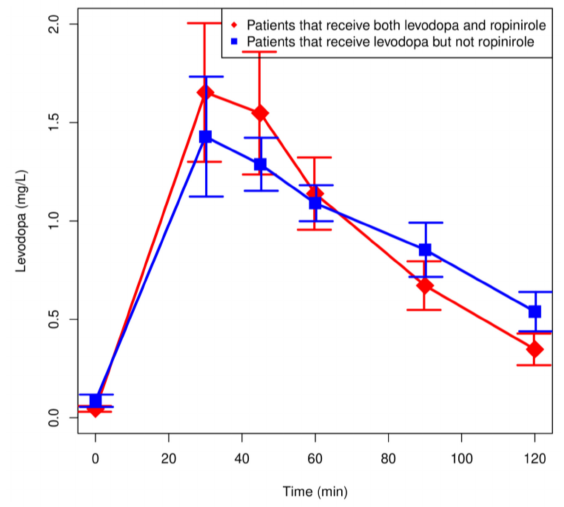
Figure 2. Plasma concentration: time profiles (mean values ± SEM) for levodopa of patients receiving both levodopa and ropinirole ( n = 13) and patients receiving levodopa but no ropinirole ( n =